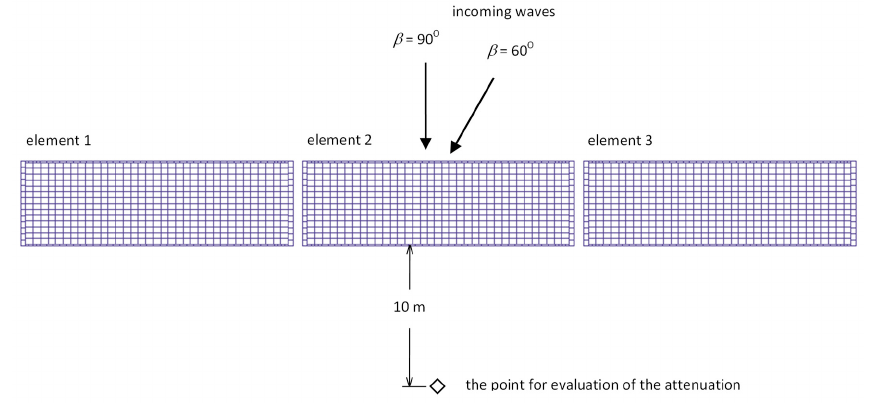
Figure 5. The position of the point where the attenuation is evaluated.